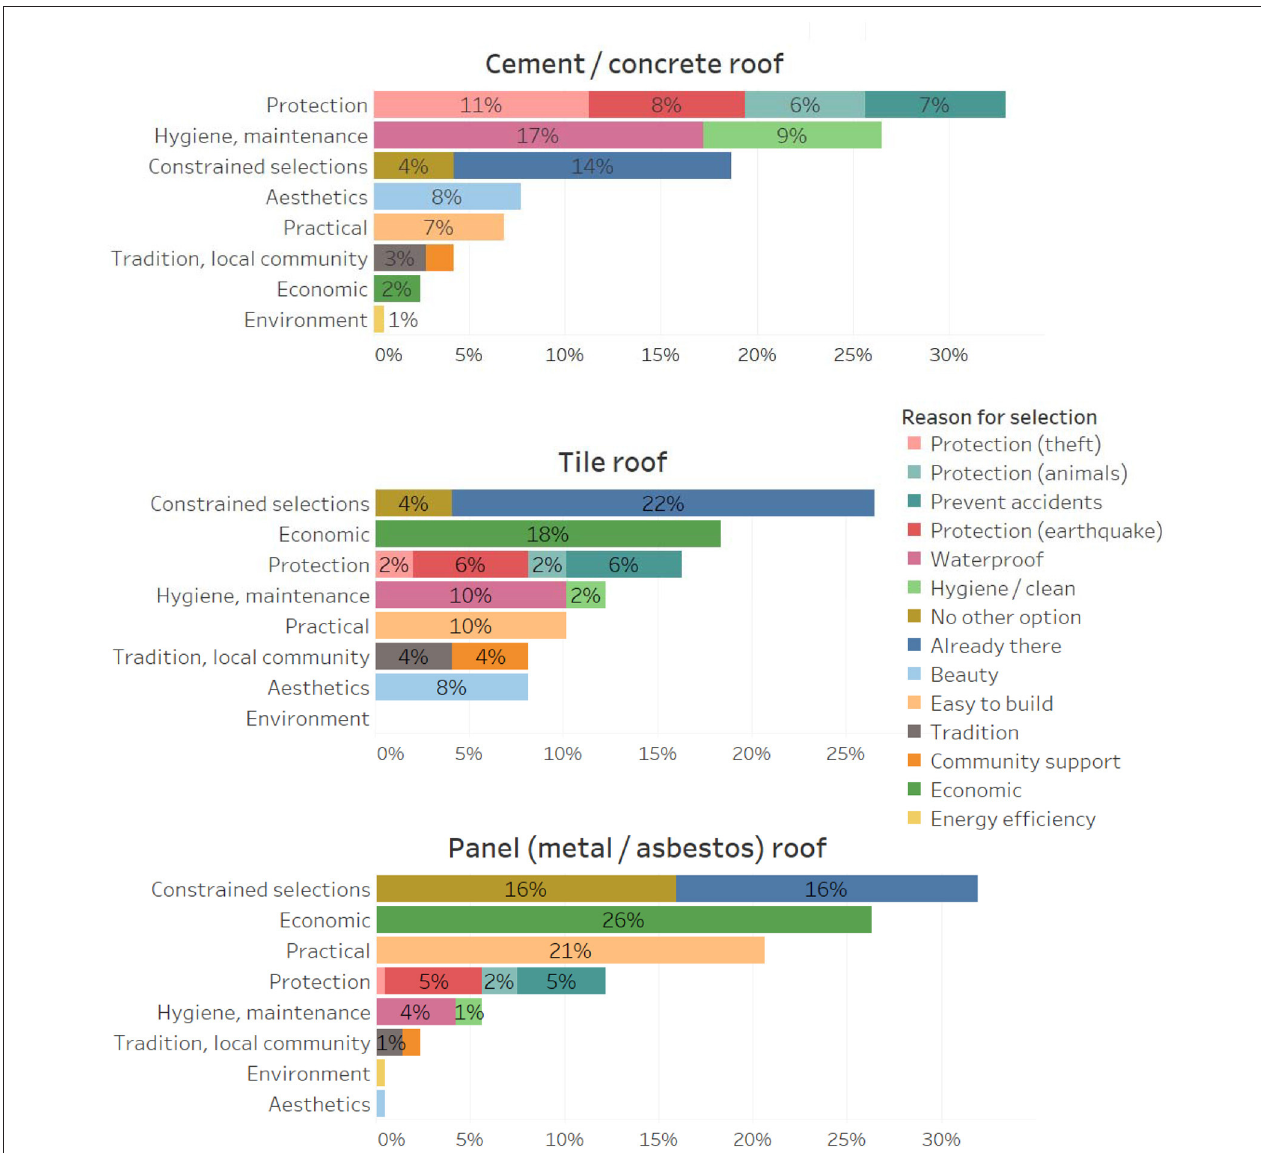
FIGURE 4 | Main reasons for roof material selection (percentage of total